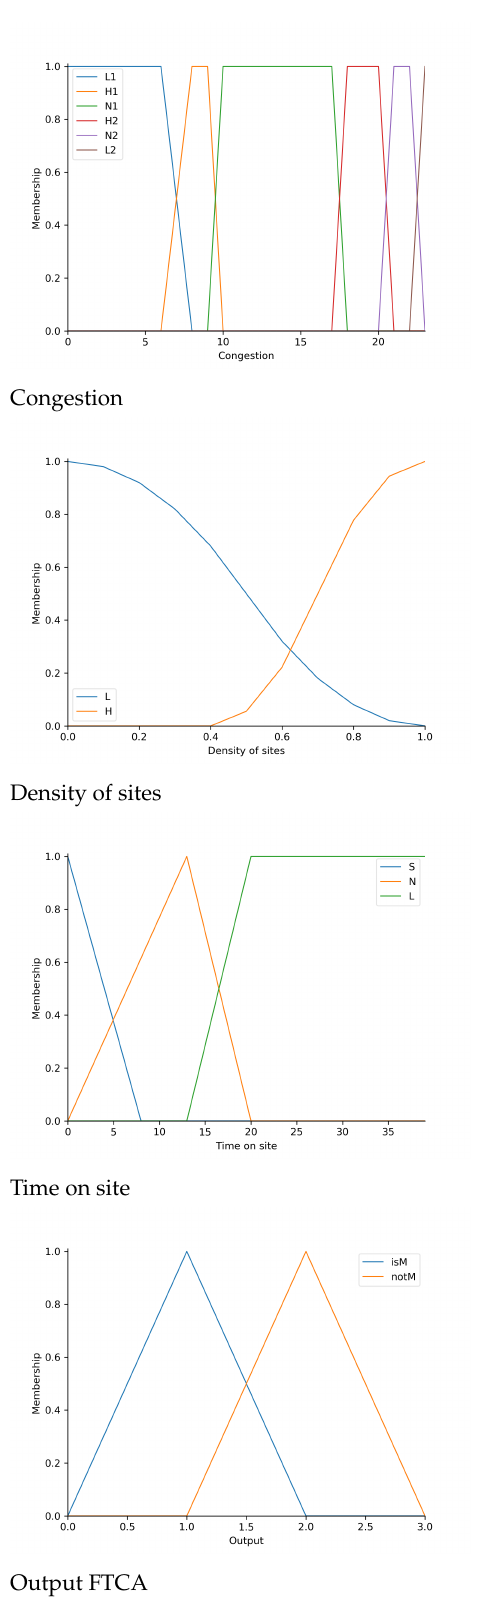
Figure 10. Membership functions for antecedent and consequent parts in FTCA. Some of the plots are expressed in logarithmic scale due the extension of Universe of